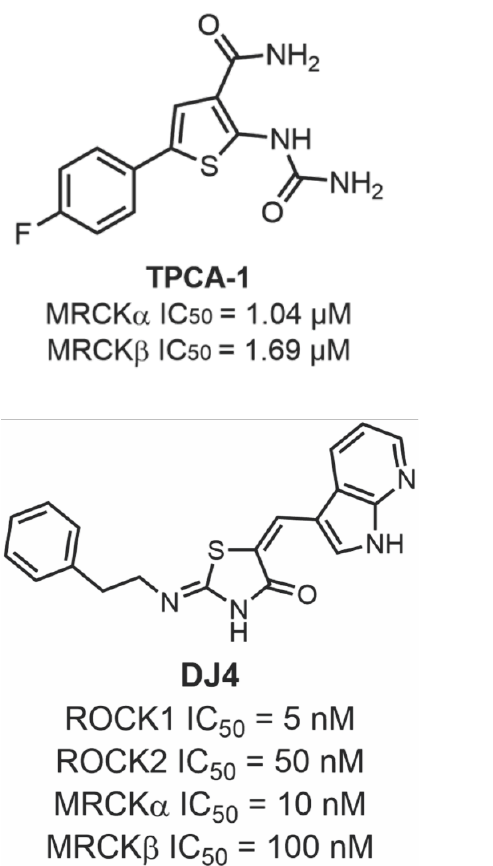
Figure 6. Structures of chelerythrine chloride, Fasudil, TPCA-1, Y-27632, and DJ4 and their inhibitory activities . ( A ). Structure of chelerythrine chloride and its inhibitory activity against MRCK α . ( B ). Structure of Fasudil, TPCA-1, and Y-27632 and their inhibitory activities against MRCK α and MRCK β . ( C ). Structure of DJ4 and its inhibitory activity against ROCK1, ROCK2, MRCK α , and MRCK β